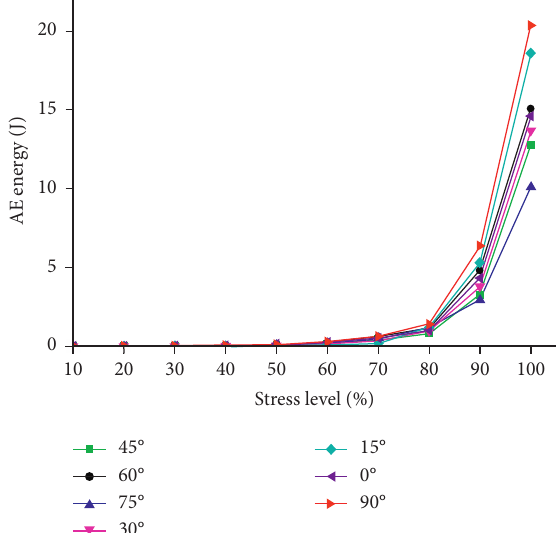
Figure 16: Relationship between distinct stress levels and AE energy.